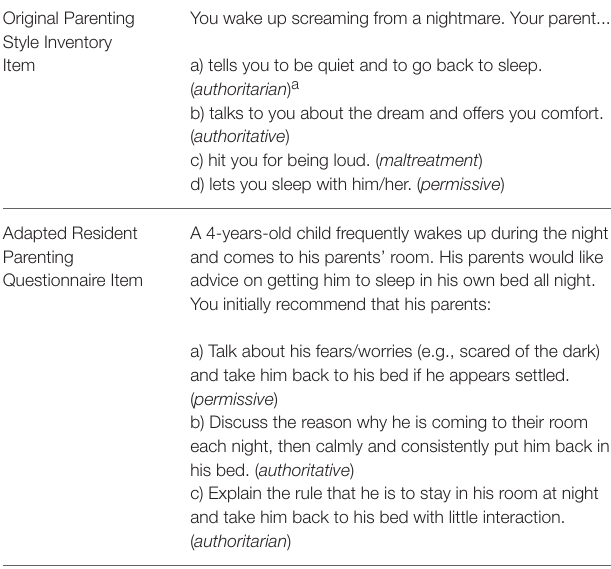
TABLE 1 | Sample adaptation of parenting style inventory item for inclusion in final version of resident parenting questionnaire parenting advice in clinic section. Original Parenting Style